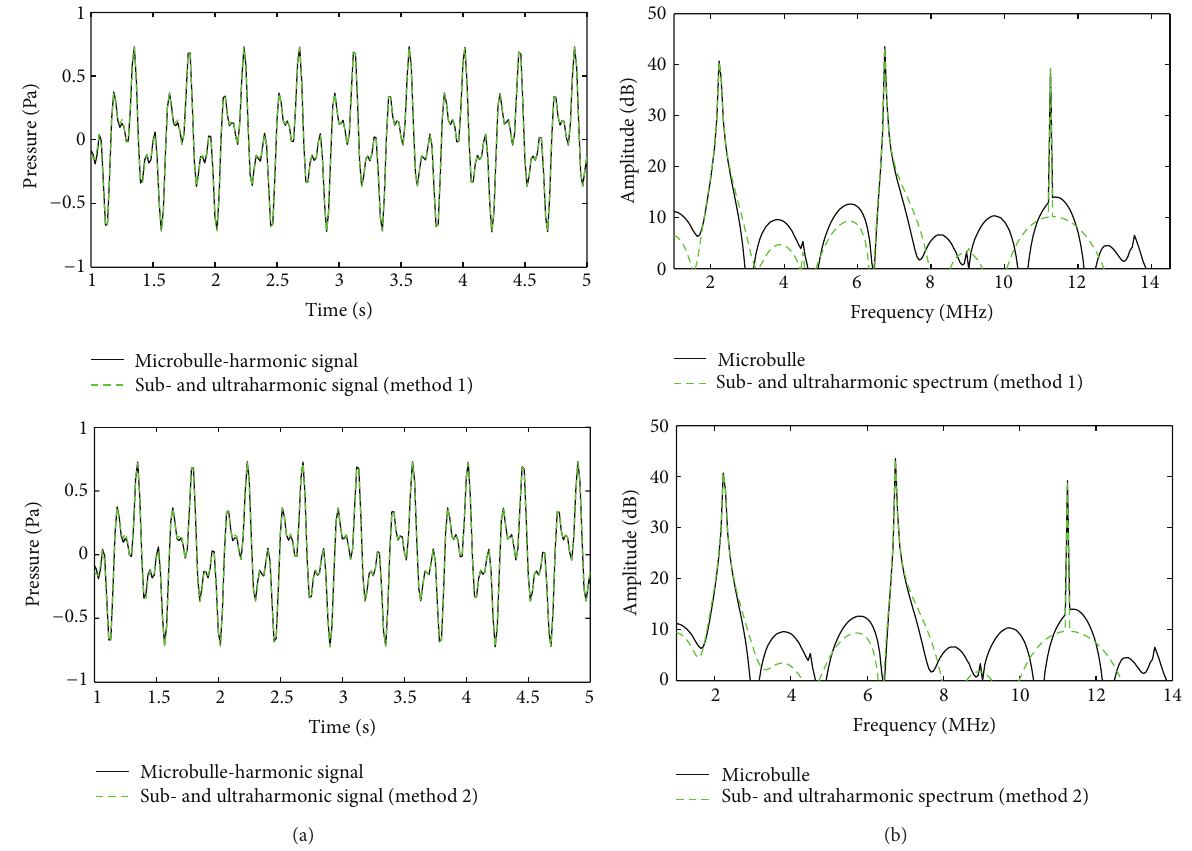
Figure 7: (a) Comparison between the backscattered difference signal between the backscattered signal by the contrast agent (black) and the SUH signal (green) modeled with (top) method 1 and (bottom) method 2. (b) Spectra of different signals presented in (a). Here SNR = ∞ dB.